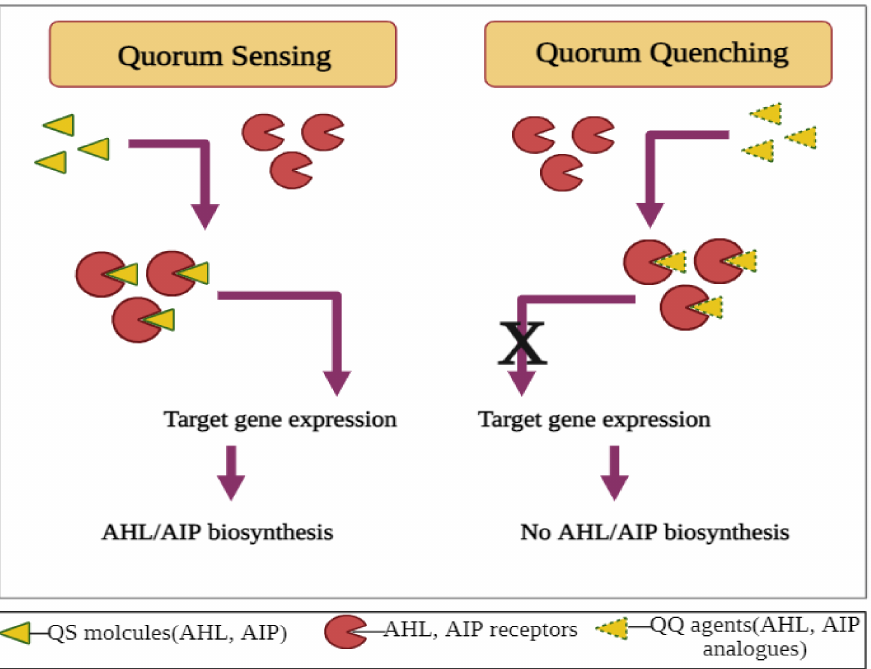
Figure 5. Diagrammatic representation of the difference between quorum sensing and quorum